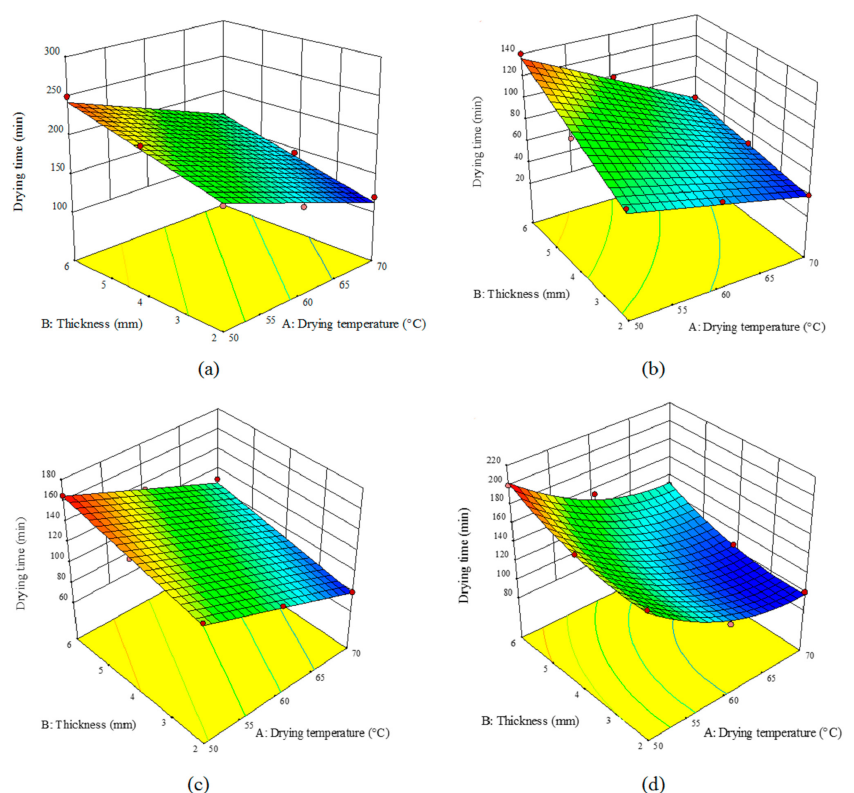
Figure 1. Effect of the drying temperature and sample thickness on the drying time (min) of the turnip slices dried under an hybrid convective-infrared (HCIR) dryer with various pretreatments ( a ) control, ( b ) microwave, ( c ) ultrasound, and ( d )